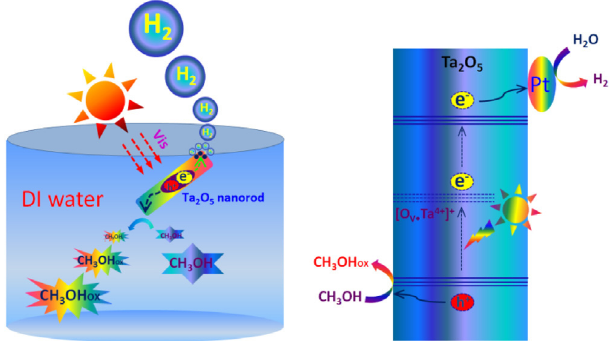
Figure 9. The schemes showing the proposed mechanism of visible light hydrogen generation on self-doped Ta 2 O 5 nanorod. Copyrights 2017 Elsevier